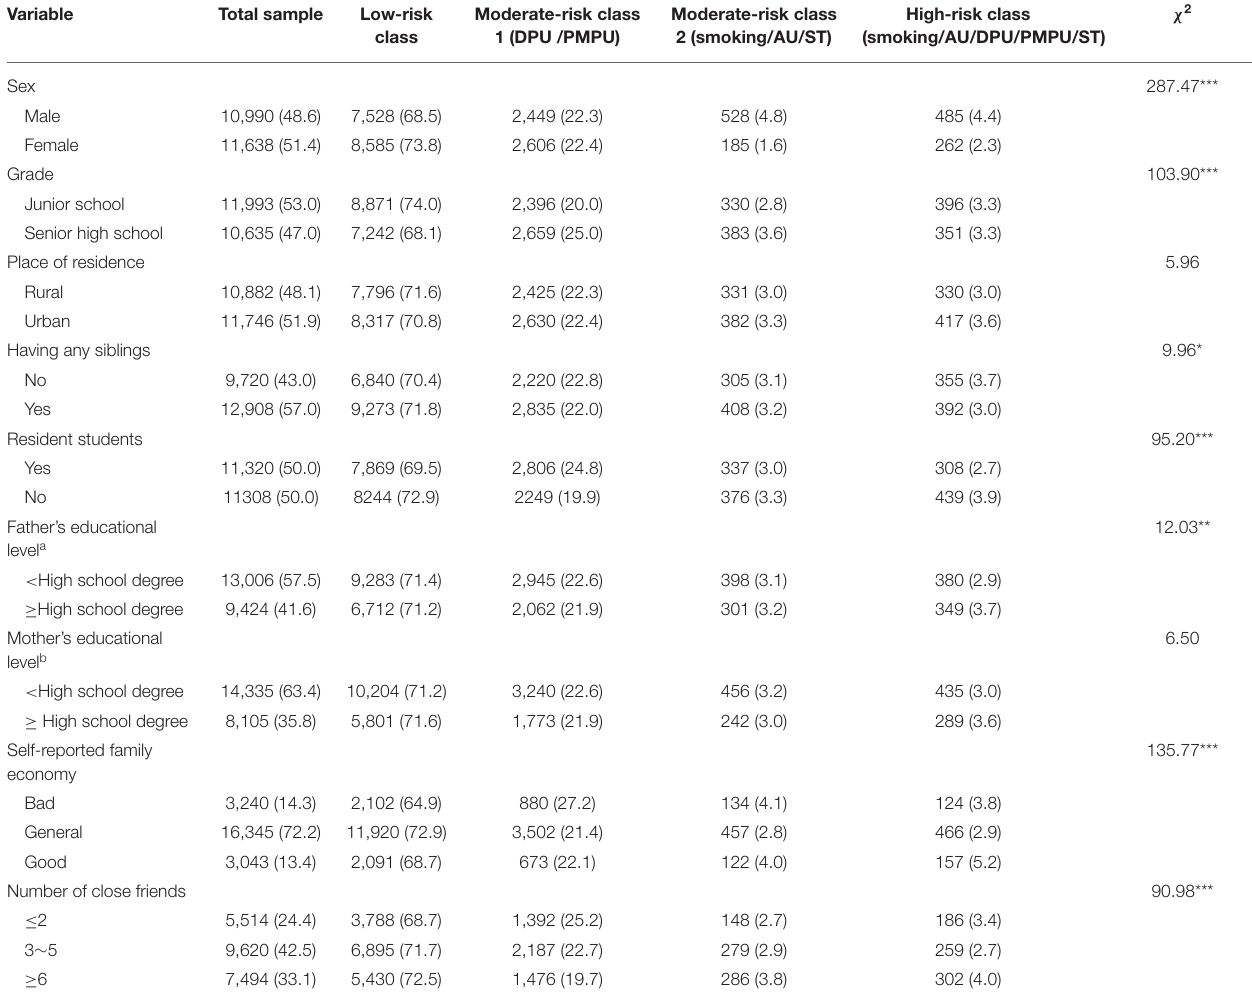
TABLE 3 | Description of students with patterns of unhealthy behaviors in Chinese adolescents. Variable